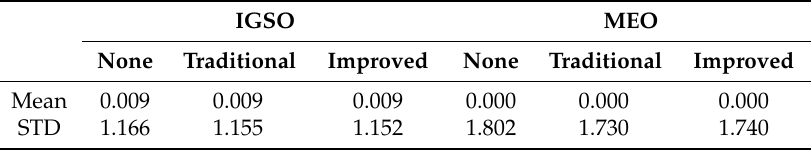
Figure 16. Histograms of all the code residuals ( left : IGSOs; right : MEOs) on XMIS (DoY 130/2015). Table 5. Mean and standard deviation (STD) values of code residuals with different processing schemes (unit: m).